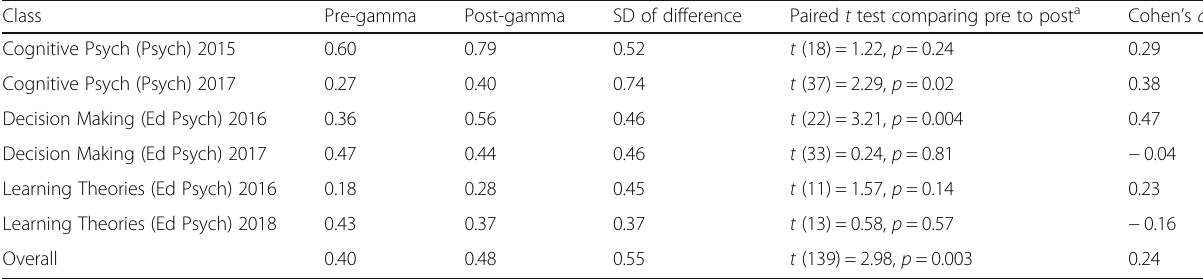
Table 4 The gamma correlation between accuracy and confidence before and after discussion for each